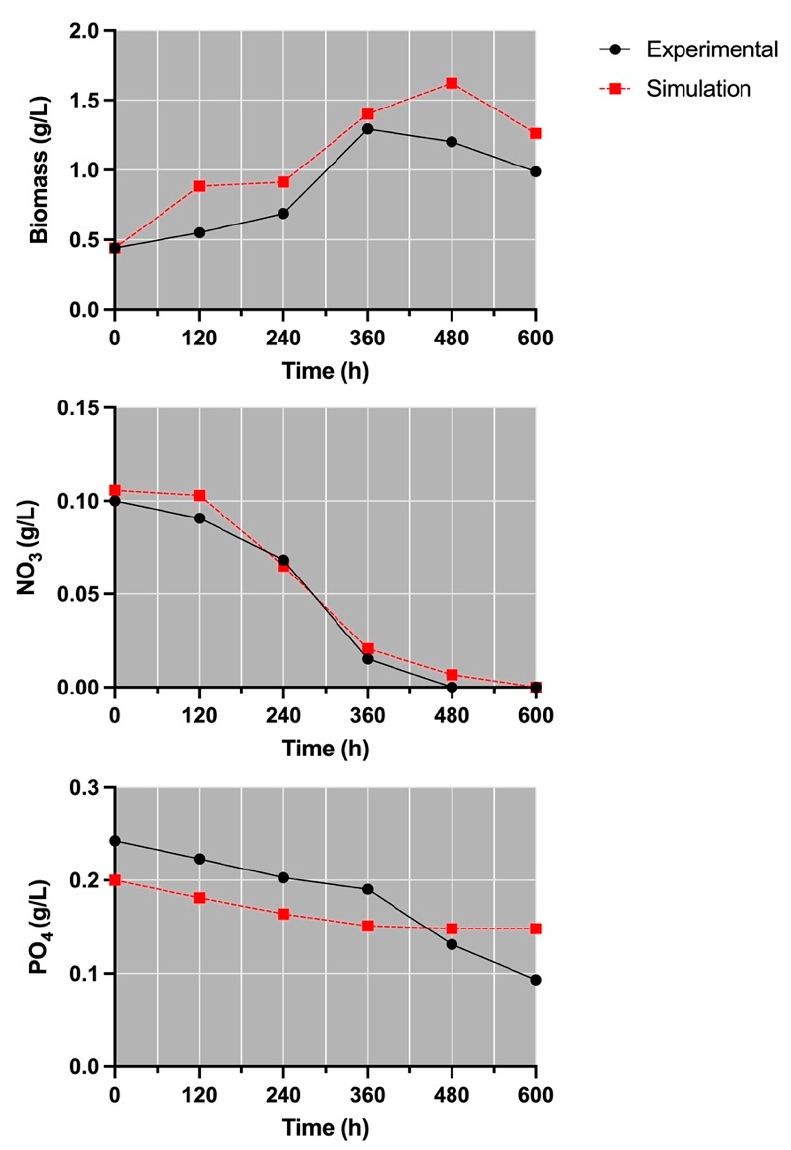
Figure 3. Graphical comparison between experimental and simulated data for biomass concentration and NO 3 and PO 4 uptakes by Chlorella sp.